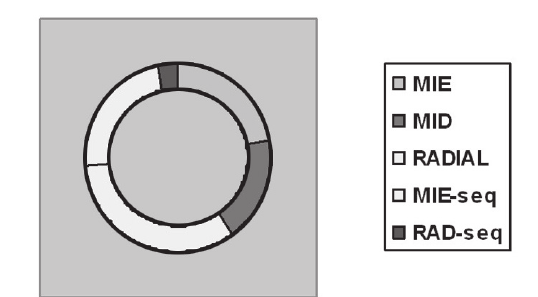
Fig. 1 - Enxertos utilizados